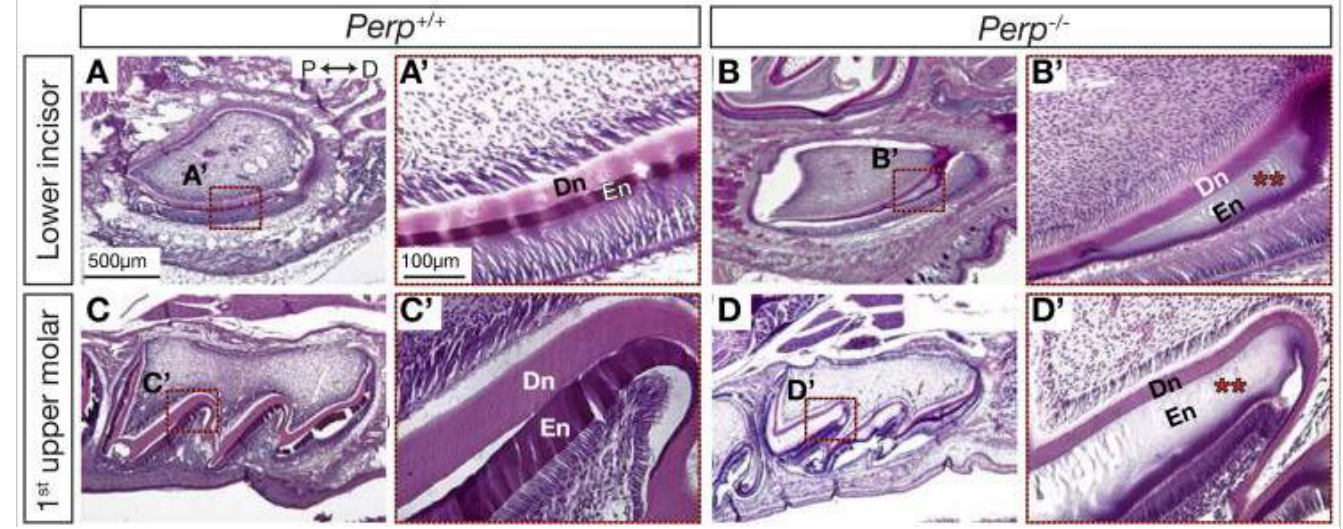
Figure 3 . H&E staining of developing mandibular incisors and maxillary molars in wild-type ( Perp +/+ ) and Perp -null ( Perp -/- ) mice at postnatal day 7 is sagittal sections. (A-D) Low-magnification images of the lower incisor and first upper molar. (A’-D’) Higher magnification images of the boxed areas. Dentin (Dn) and enamel (En) are denoted by yellow and red arrowheads, respectively. Areas of defective enamel are denoted by red asterisks in the incisors and molars of Perp -null mice. P, proximal; D,